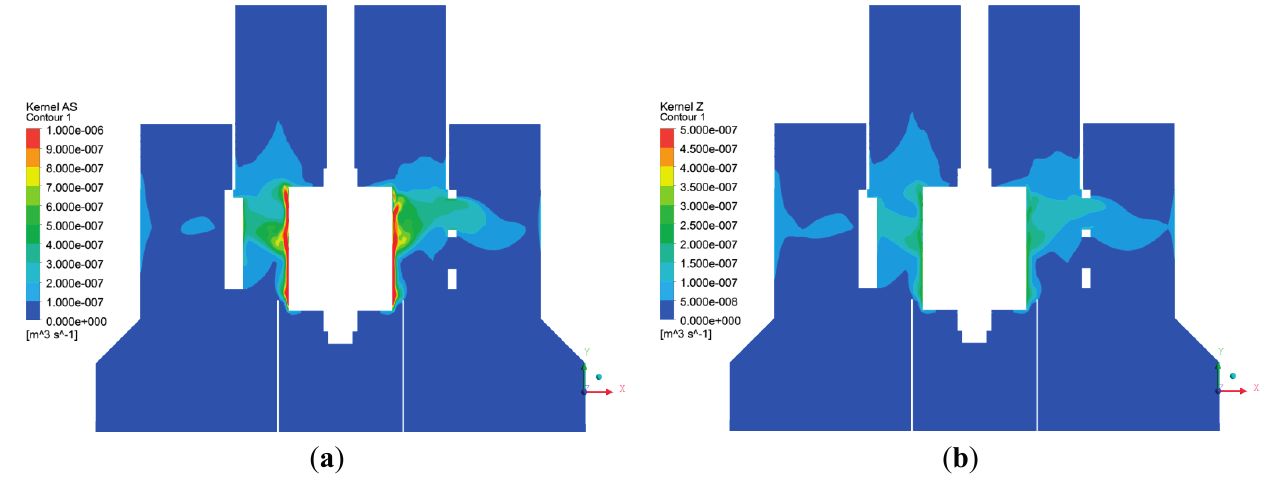
Figure 10. ( a ) Abrahmson-Schubert [6] collisions kernel for d p = 100 micron; ( b ) Zaichik et al. [9] collisions kernel for d p = 100 micron.